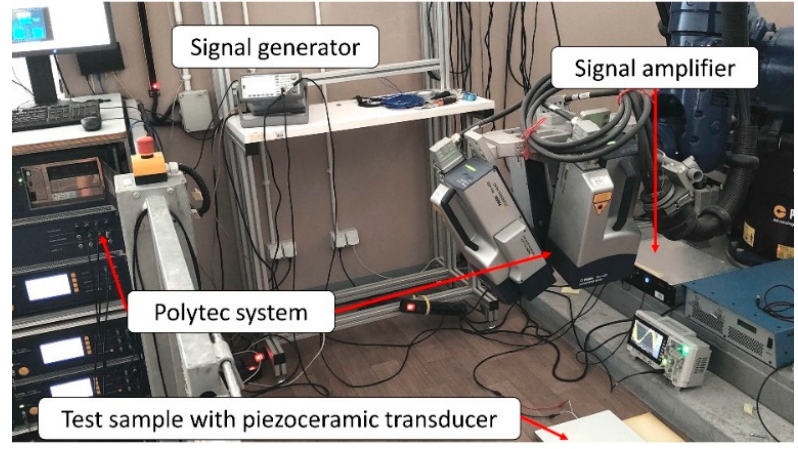
Figure 5. Measurement system used in experiments—configuration with piezoceramic transducer.